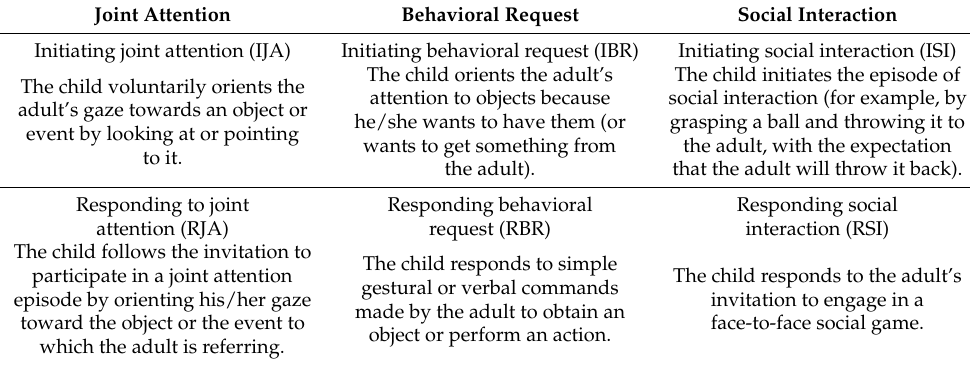
Table 2. Early communication skills assessed with the